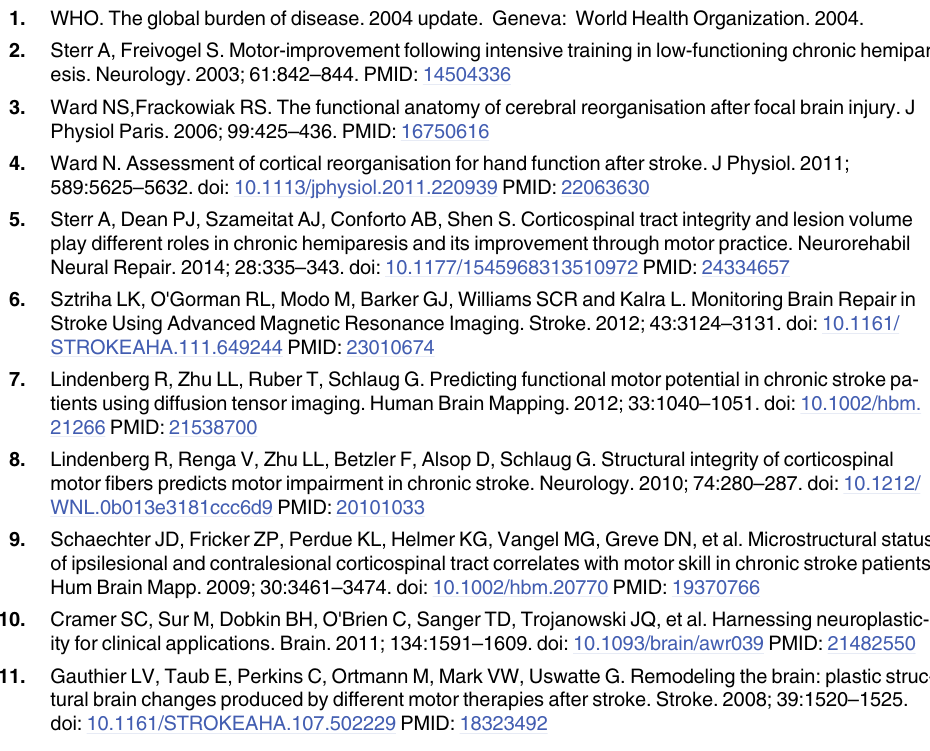
S1 Table. Motor-related supratentorial brain regions volumes in stroke patients and nor- mal